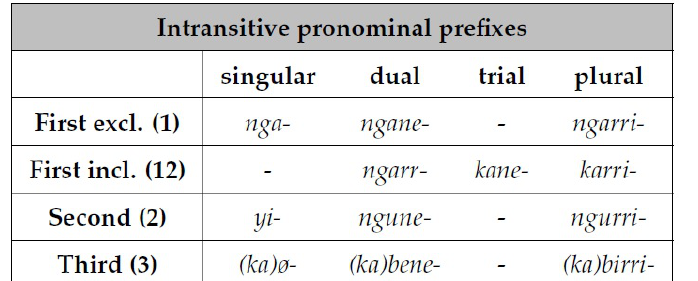
Table 1. Kunwinjku intransitive pronominal prefixes schematised by relative number, resulting in a much neater paradigm arrangement.